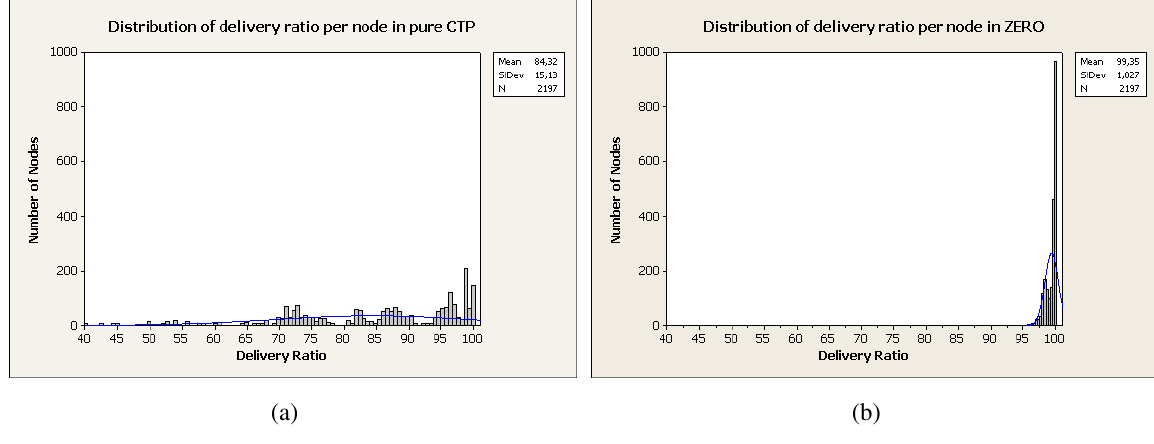
Figure 7. Distribution of delivery ratio per node. (a) CTP, (b)